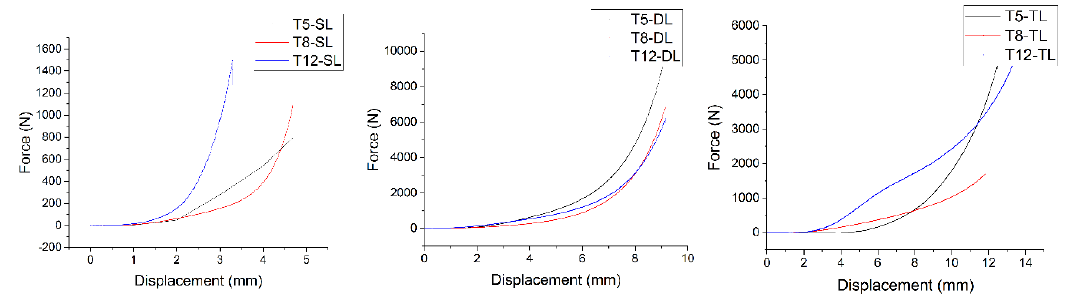
Figure 16. Maximum result of single layer (SL), double layer (DL), and triple layers (TL) for the trials (5,8,12).